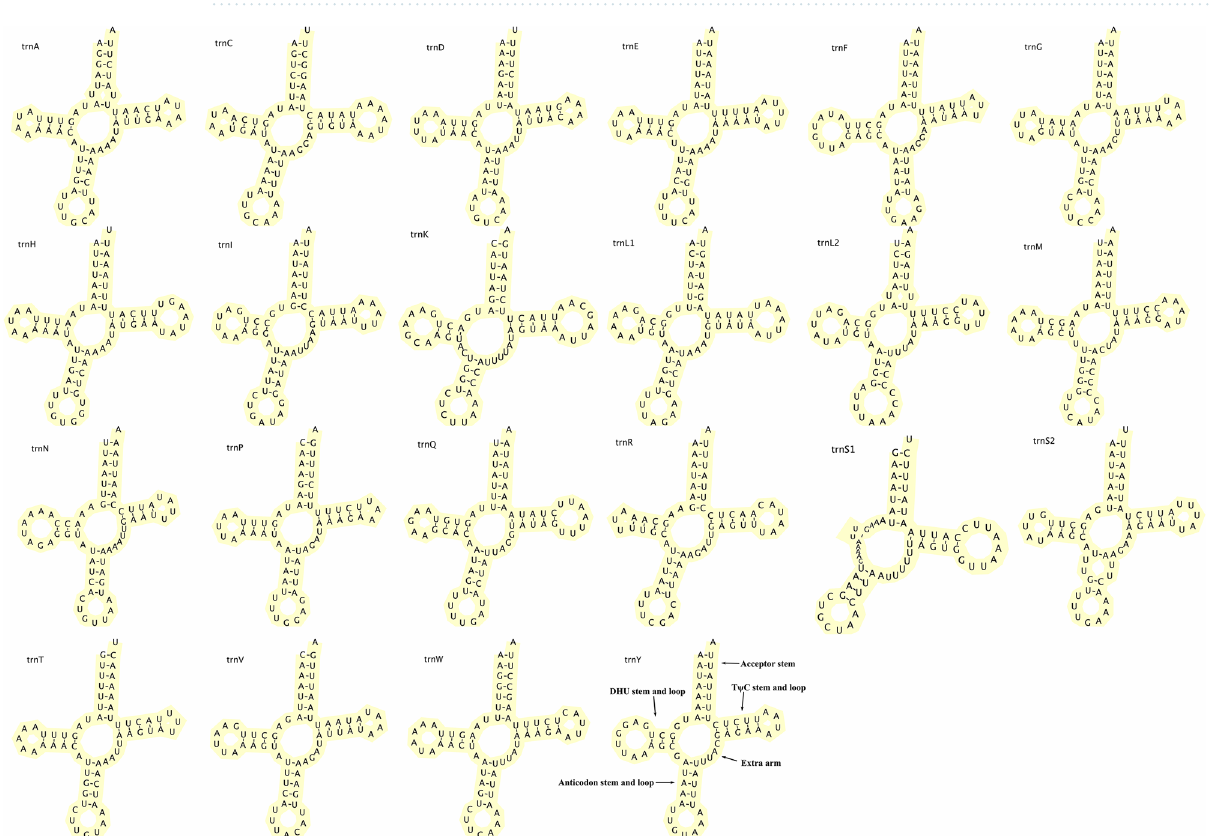
Figure 5. Predicted secondary structures for the 22 S. retorta mitogenome-encoded